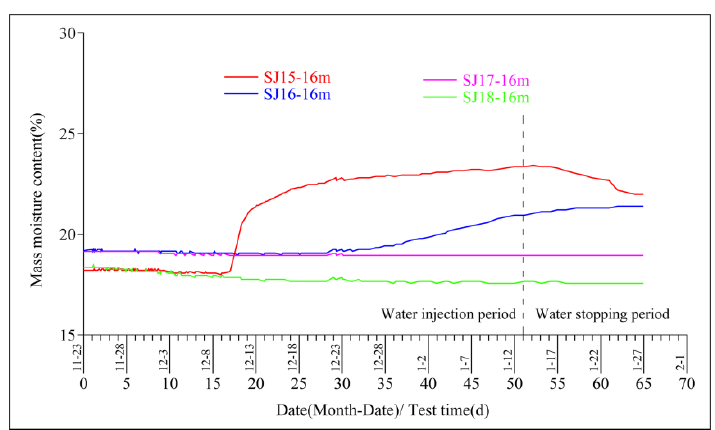
Figure 9. Moisture meter monitoring curves.